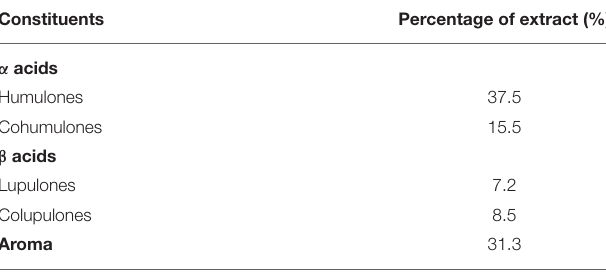
TABLE 1 | Composition of hop